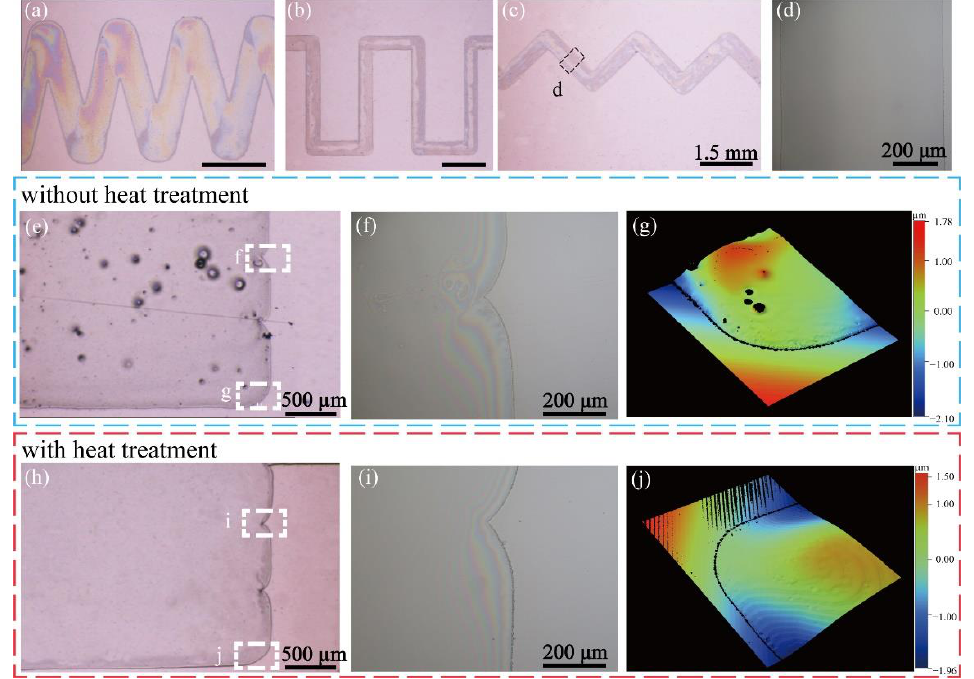
Figure 3. Optical microscope images of patterned PVA films that were prepared using micro-pen writing. ( a – c ) Different patterned PVA films. All scale bars in ( a – c ) are 1.5 mm. ( d ) Partial enlarged drawing of the patterned PVA film. ( e ) The written PVA film was placed in the cleanroom for 1 h without heat treatment. ( h ) The written PVA film was heated at 55 °C for 9 min after writing and placed in the cleanroom for 1 h. ( f , i ) Interference fringes of the combined area photographed using an optical microscope. ( g , j ) Fringe thickness measurement using an optical profilometer.